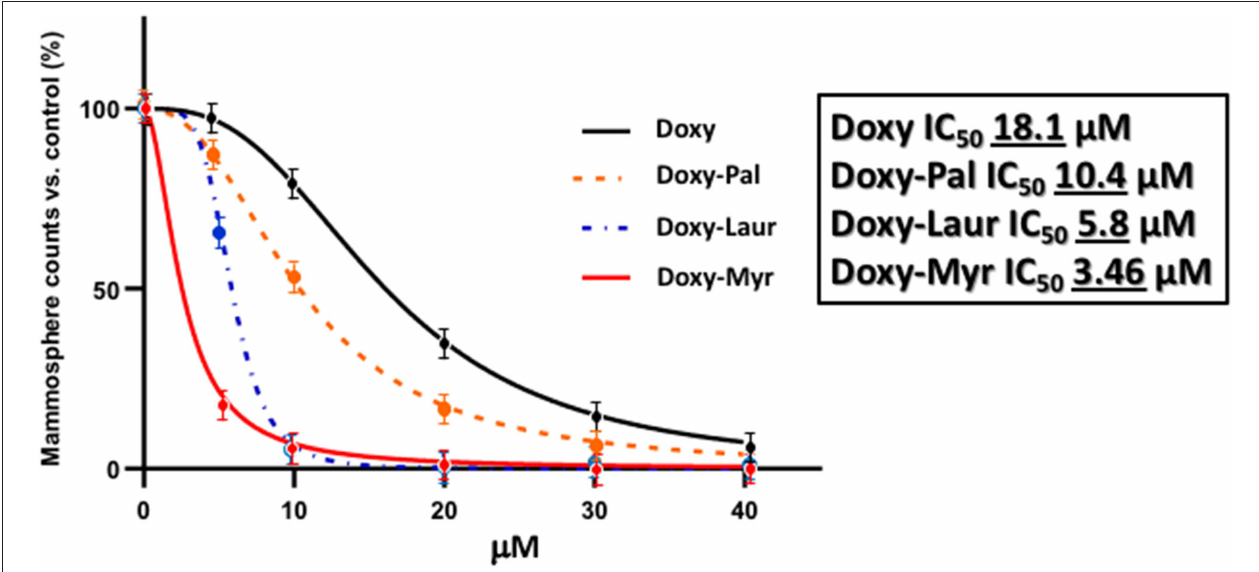
FIGURE 8 | Rank order potency of the new Doxycycline derivatives. Note that Doxy-Myr is the most potent Doxycycline derivative for targeting CSC propagation, as assayed using the 3D mammosphere assay to quantitatively measure anchorage-independent growth. The rank order potency is Doxy-Myr > Doxy-Laur > Doxy-Pal > Doxycycline.